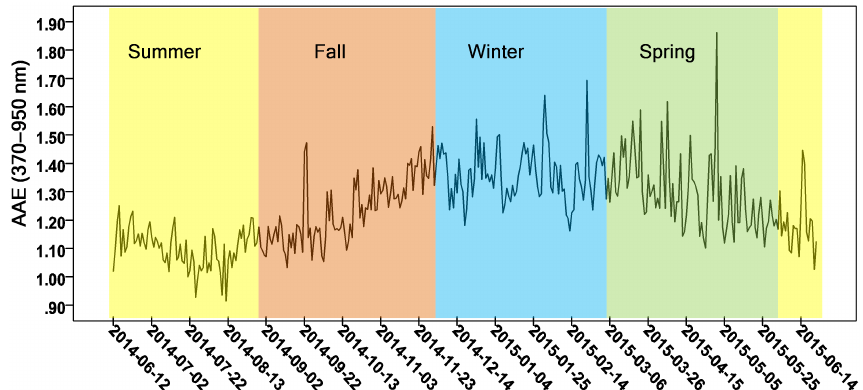
Figure 2. Annual variations in AAE (370–950nm) at the Vavihill measurement station. Colors represent different seasons of the year. N =